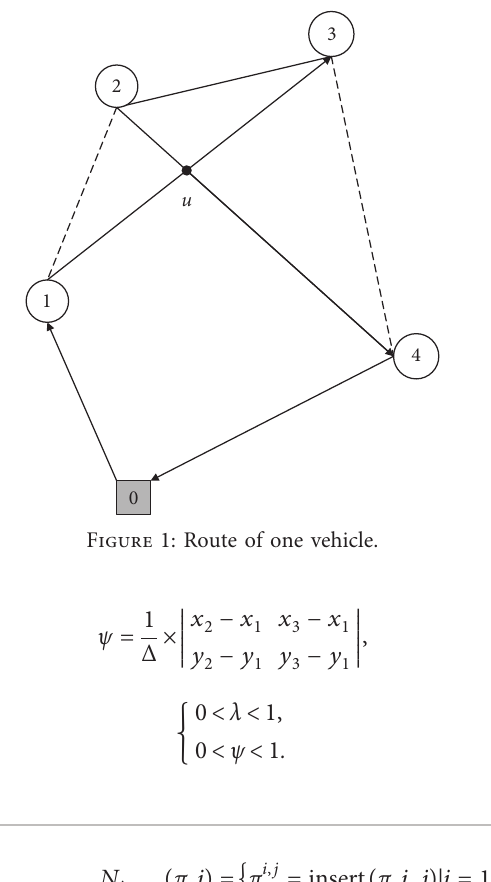
Figure 1: Route of one